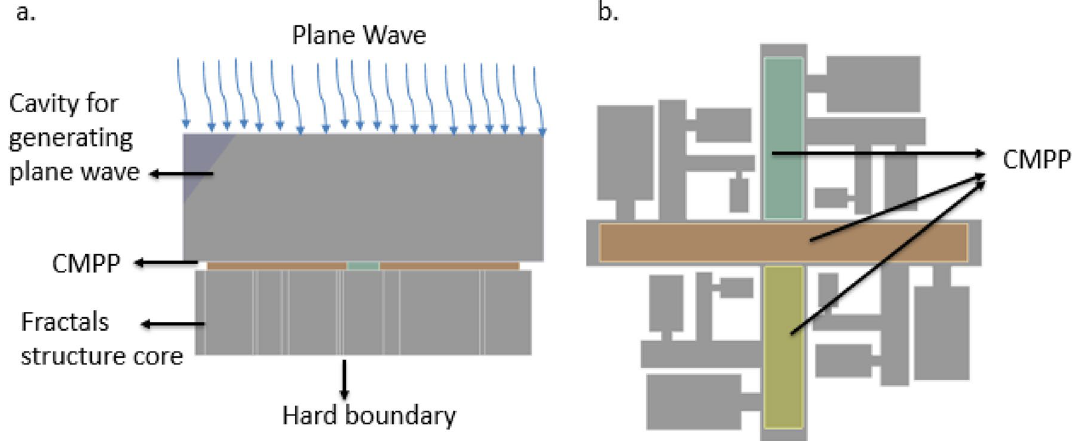
Figure 7. FEM simulation setup to analyze the sound absorption coefficient. ( a ) Simulation setup. ( b ) Equivalent fluid model of proposed CMPP fractals acoustic metamaterials. Courtesy (ANSYS 17.0 45